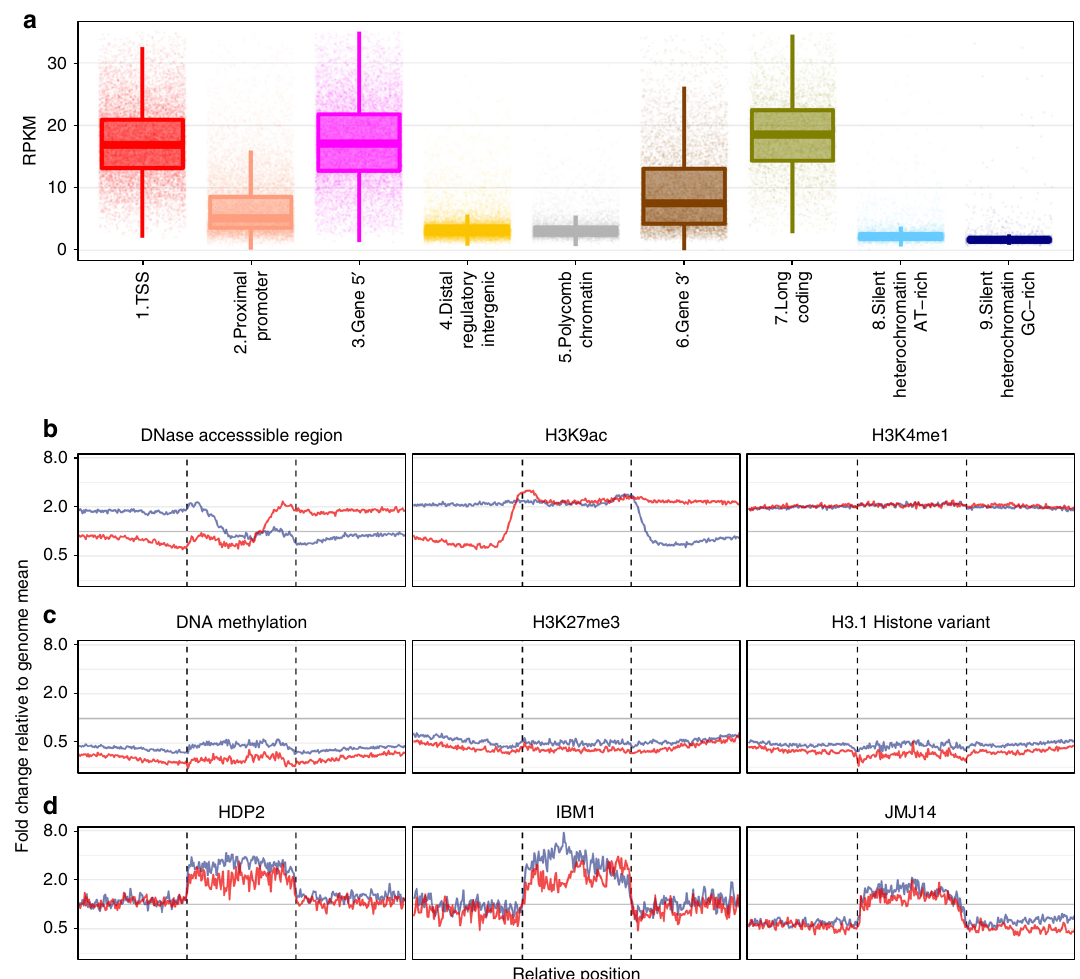
Fig. 2 Chromatin state in fl uence on genome-wide kinetics of nucleotide excision repair. a The level of excision repair for each chromatin state. In the boxplot, the middle line corresponds to median, the lower and upper hinges correspond to fi rst and third quartiles. The whiskers extend from hinges to 1.5*IQR (inter-quartile range, the range between fi rst and third quartiles). The excision repair pro fi les ( b ), at the sites of DNAse hypersensitivity, H3K9 acetylation, H3K4 monomethylation ( c ), in regions of DNA methylation, H3K27 trimethylation and H3.1 histone variant binding. d The change of excision repair level at the binding sites of HDP2, IBM1 and JMJ14. b – d The regions between vertical dashed lines are the sites (scaled to percentage) where the factor interacts with DNA and each fl anking site is 1 kb. The log2-scaled y -axis show untransformed values of fold-change. The horizontal gray line ( y = 1) is where the signal is equal to the genome mean. Blue and red represent plus and minus strands,